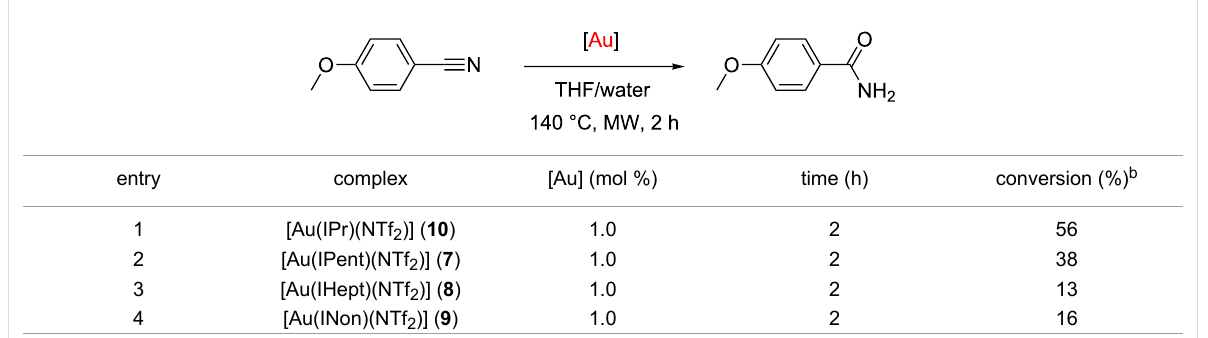
Table 2: Influence of the ITent ligands in gold-catalysed nitrile hydration. a